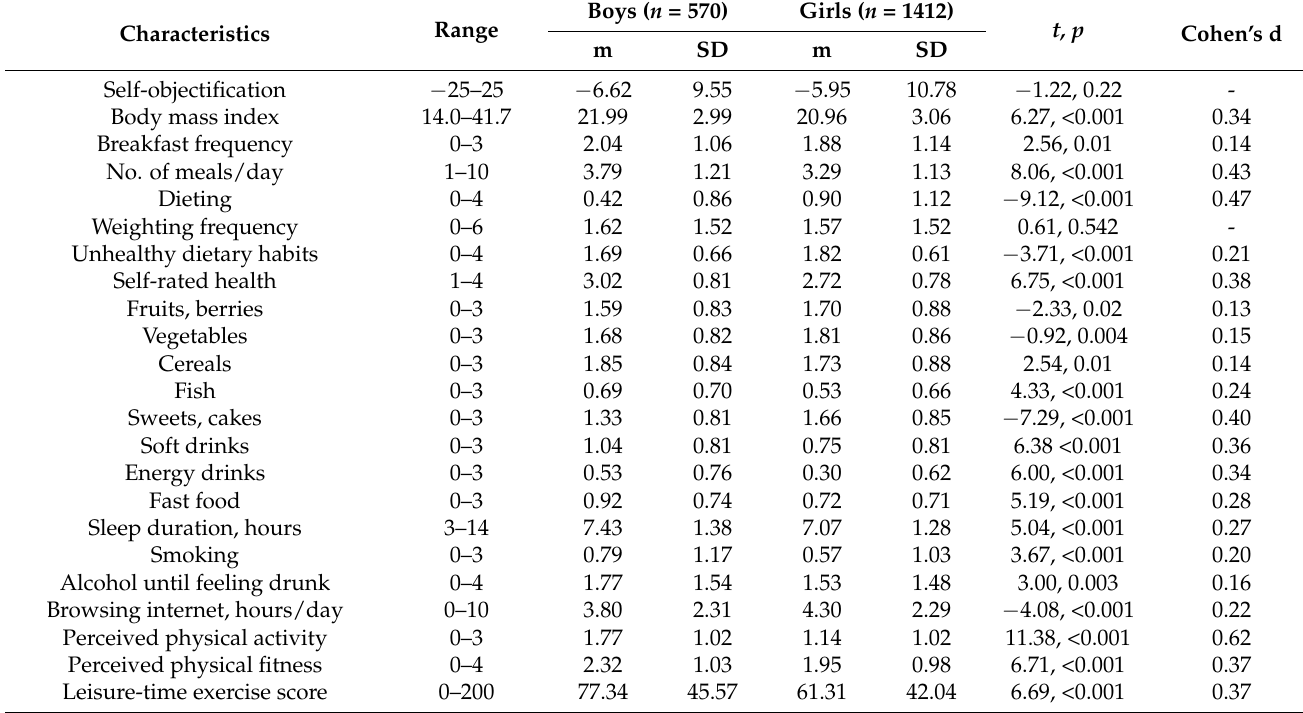
Table 1. The comparison of the self-objectification and lifestyle habits in adolescent boys and girls ( n = 1412).